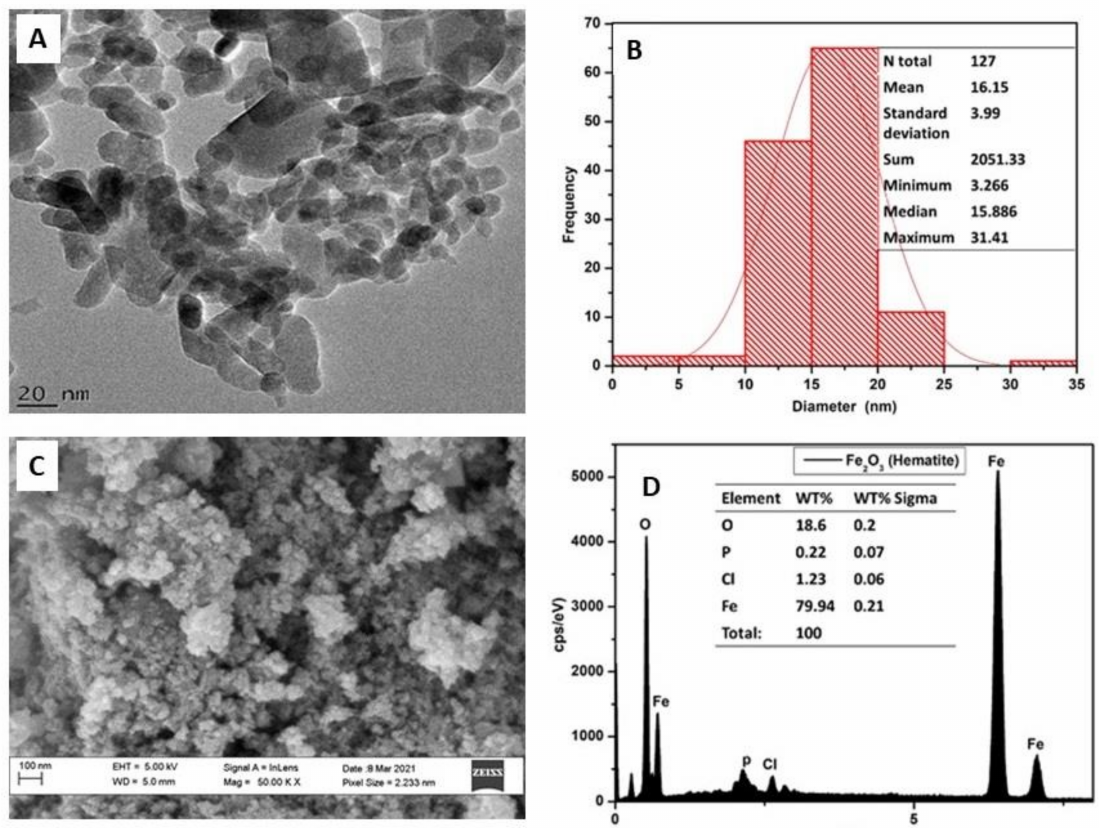
Figure 2. Structure, morphology, and size of green-synthesized α Fe 2 O 3 NPs after annealing at 600 ◦ C for 2 h. HRTEM micrograph showing shape, sizes, and distribution of hematite NPs ( A ), histogram size analysis of NPs ( B ), HRSEM micrograph showing the surface morphology of the synthesized NPs ( C ), and HRSEM-EDX showing weight-percentages composition and distribution of elements in NPs ( D